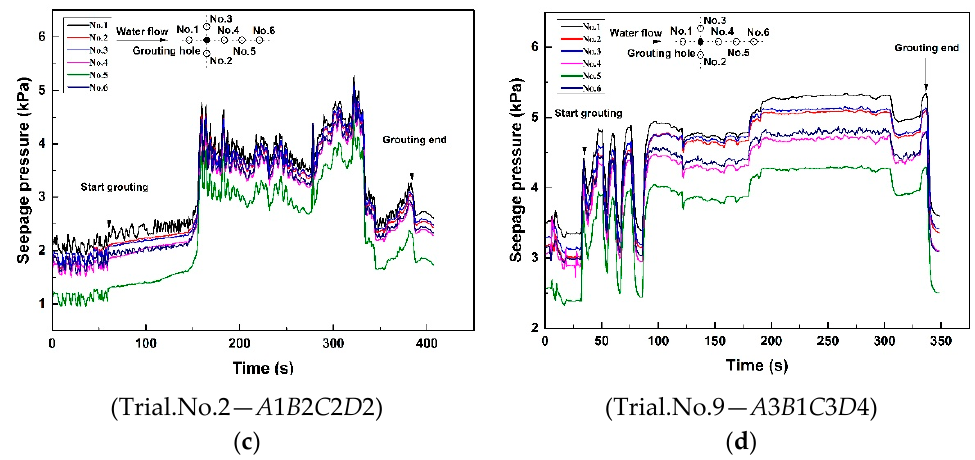
Figure 9. The types of seepage pressure change curves. ( a ) “Single peak type” of seepage pressure. ( b ) “Multi-peak type” of seepage pressure. ( c ) “Multi-peak type” of seepage pressure. ( d ) “Platform type” of seepage pressure.